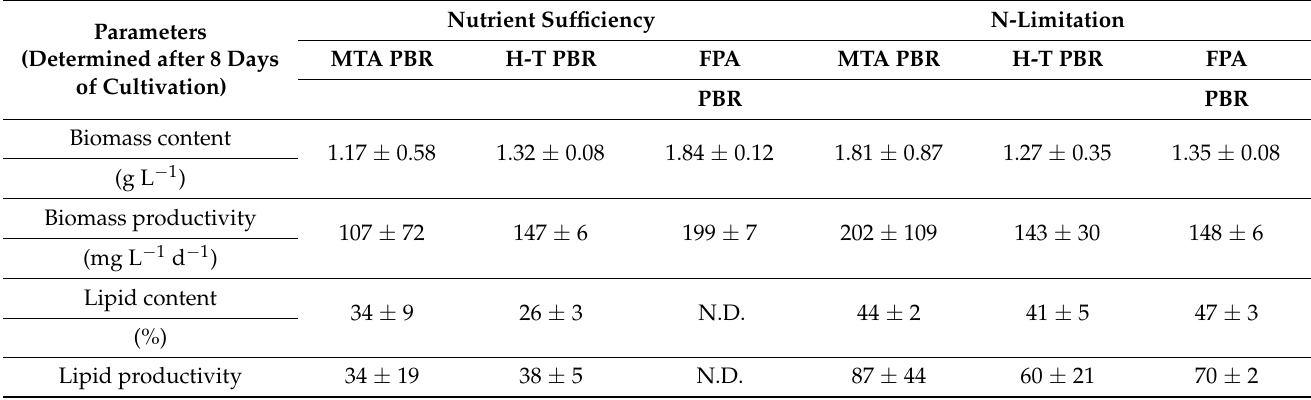
Table 1. Biomass and lipid accumulation in C. pyrenoidosa cultures cultivated under nutrient sufficiency (full BG-11 medium) and under N limitation (BG-11 medium with 10 times lower N content) in the Multi-tubular airlift photobioreactor (MTA PBR), Helical-tubular photobioreactor (H-T PBR) and Flat panel photobioreactor (FPA PBR, for details on PBRs construction see Figure 1). The data represent mean values ± standard deviations, n = 2–4. In both 2018 and 2019, no significant differences in biomass or lipid accumulation and production were found between individual photobioreactors (ANOVA followed by Tukey’s HSD test: p > 0.05). N.D.: not